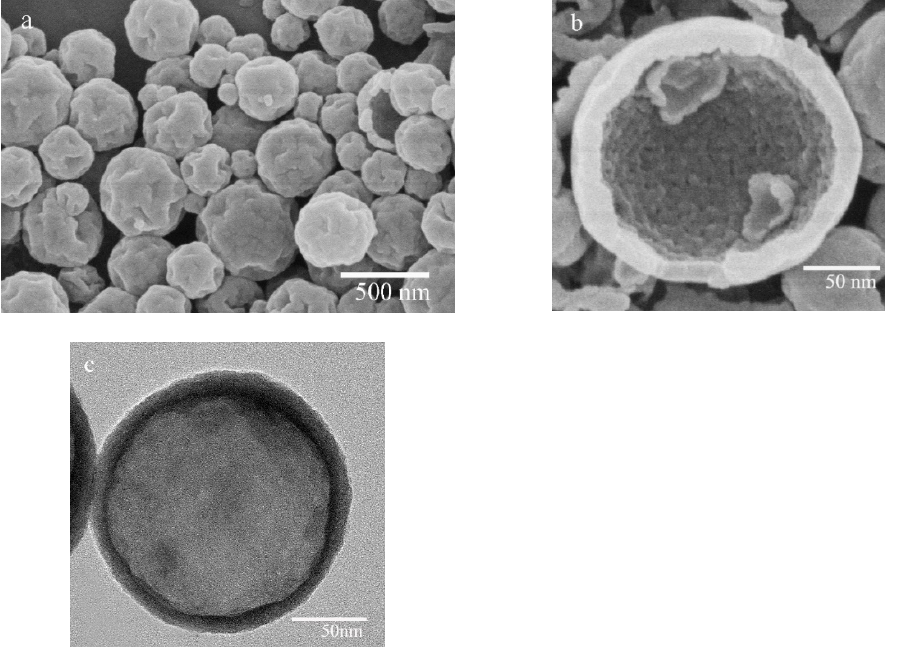
Figure 4. Electron micrographs of ( a ) silica - based nanocapsules by FE - SEM, ( b ) broken capsules by FE - SEM, ( c ) by TEM.